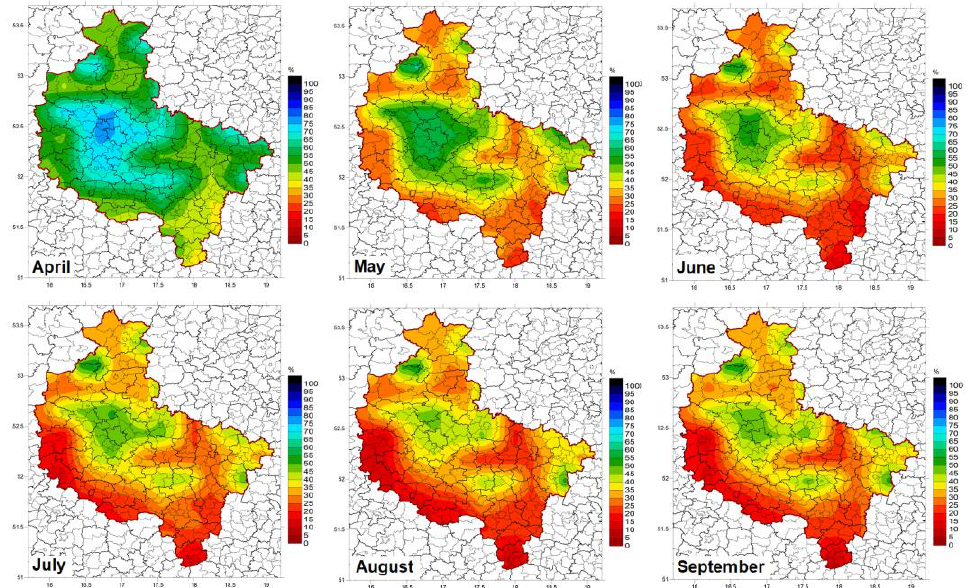
Figure 6. Soil moisture index [%] in the 28 – 100 cm layer in the following months of the growing season (April – September) 2018 . season (April–September)